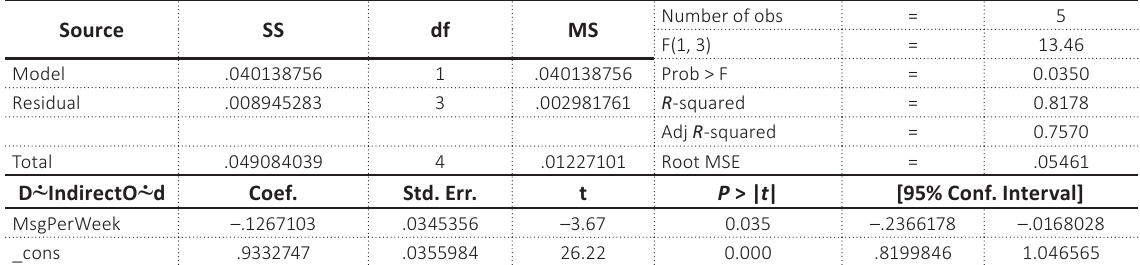
Table 4. Direct open rate determined by frequency – regression results